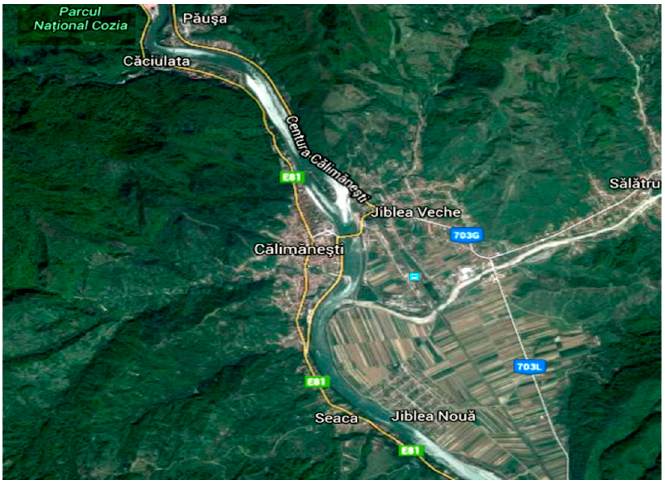
Figure 10. Position and components of C ă lim ă ne ș ti town (from Google maps).